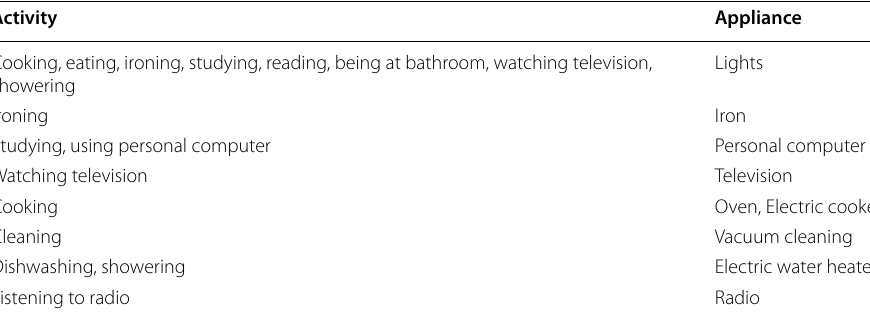
Table 1 Mapping between activities and appliances